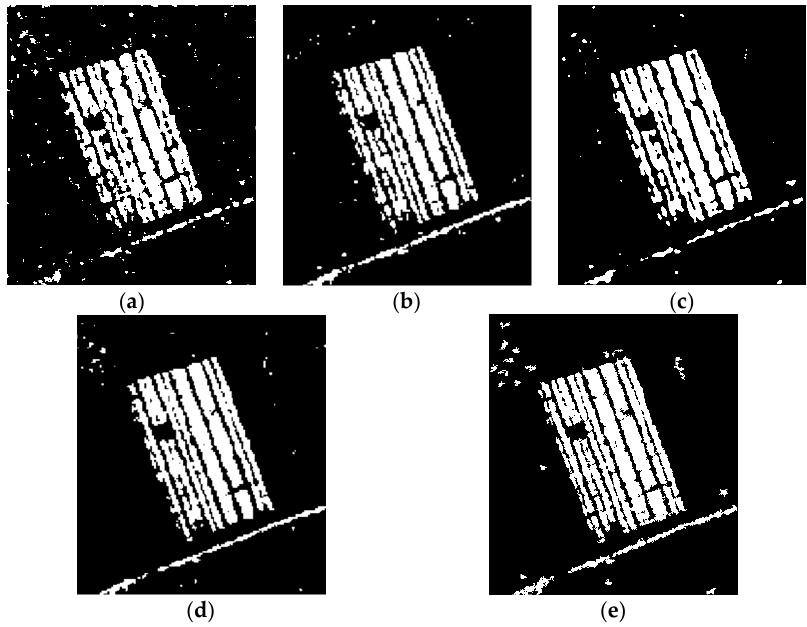
Figure 10. Change detection results generated by different methods on the Yellow River dataset. ( a ) Result by PCAKM. ( b ) Result by MRFFCM. ( c ) Result by GaborTLC. ( d ) Result by D_MRFFCM. ( e ) Result by the proposed method. Table 1. Change detection results of different methods on the Yellow River dataset.